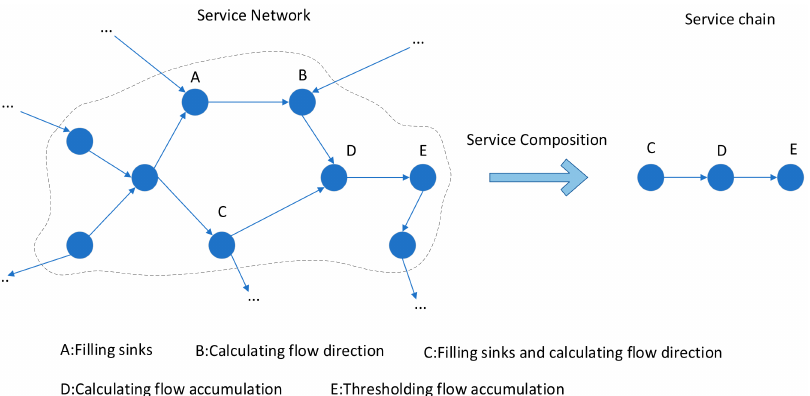
Figure 1. Relationship between service network, service composition, and service chain. This figure shows the river network extraction service chain extracted from the service network by the service composition, which can be used to solve river network extraction problems and realize value-added